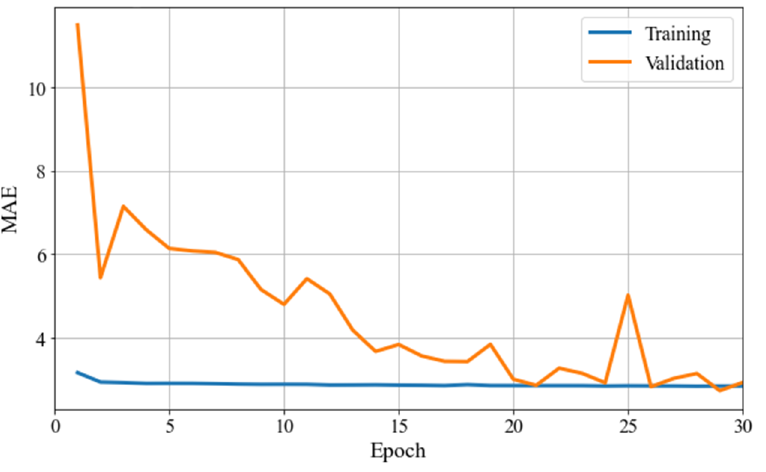
Figure 17. Training and validation losses of the MLP model in the holdout method.